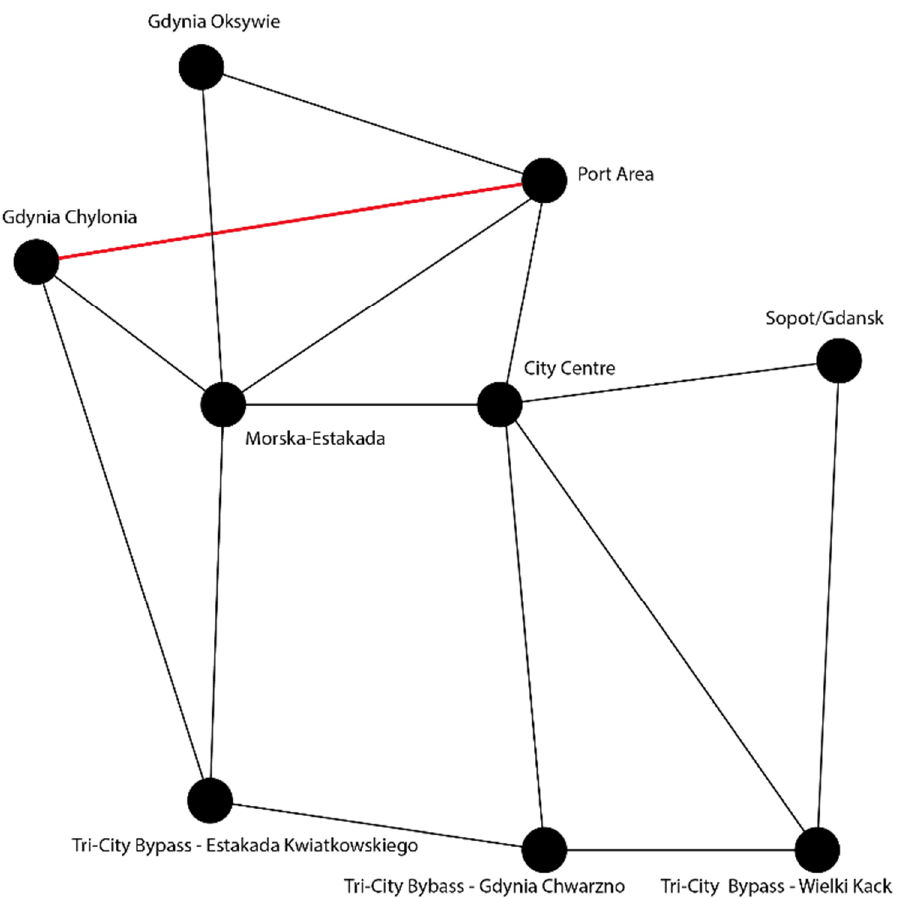
Figure 12. Graph theory model of the analysed road network in Gdynia with “Red Road”.